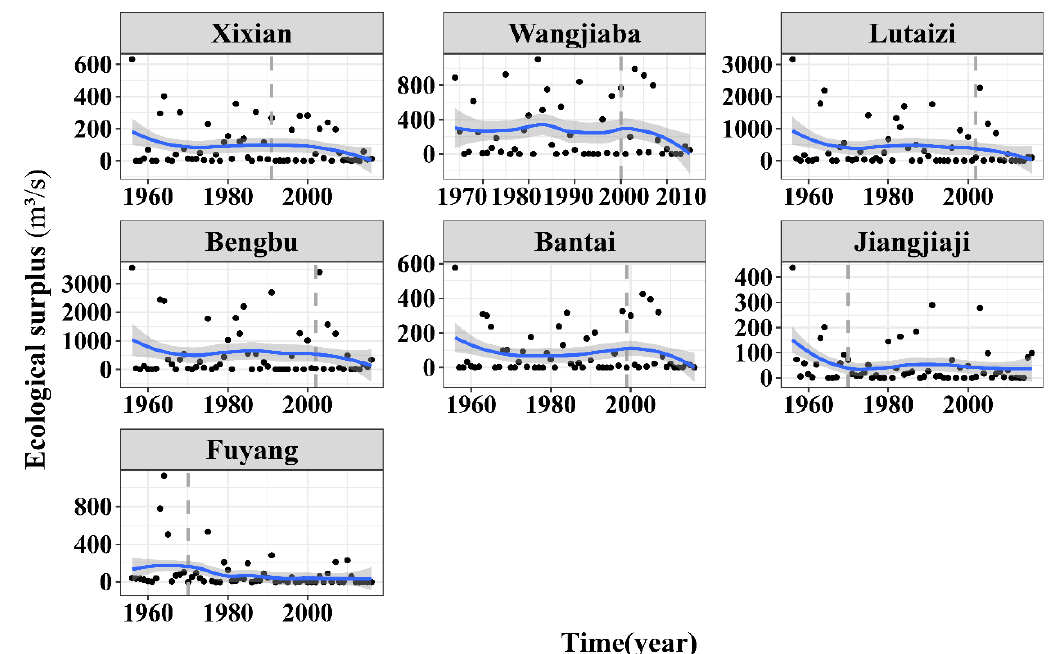
Figure 9. The trend change of the eco-surplus in the HRB.